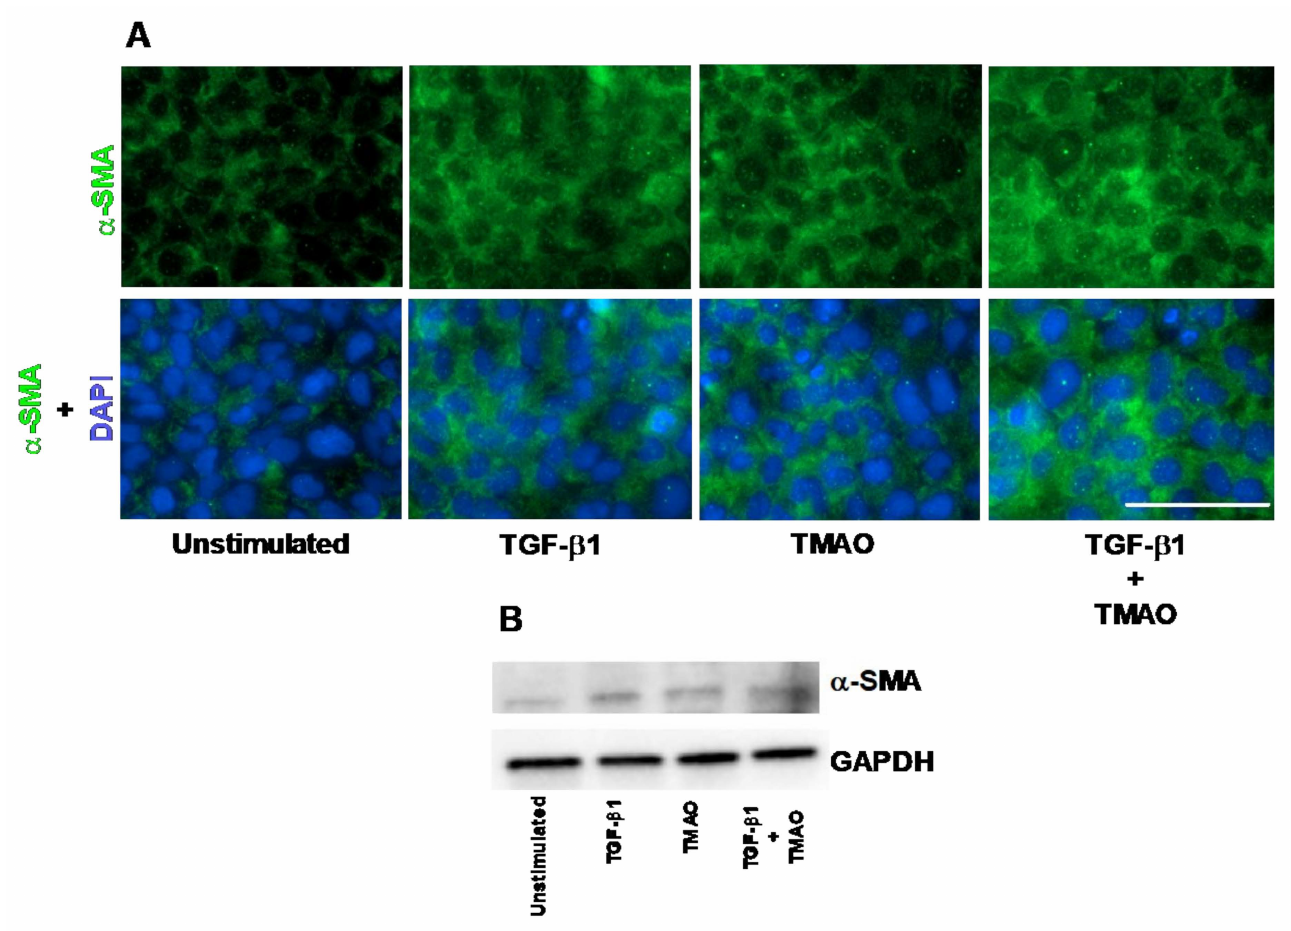
Figure 1. Trimethylamine N-oxide (TMAO) promotes renal fibroblast activation. Renal fibroblasts were stimulated with 300 µ M TMAO and 10 ng/mL TGF- β 1 for 24 h and α -SMA expression was visualized with fluorescence microscopy ( A ) and Western blot ( B ). Green represents α -SMA (smooth muscle actin) and blue (DAPI) represents the nucleus. Scale bar represents 100 µ m. GAPDH was used as a loading control. Data are representative of three independent